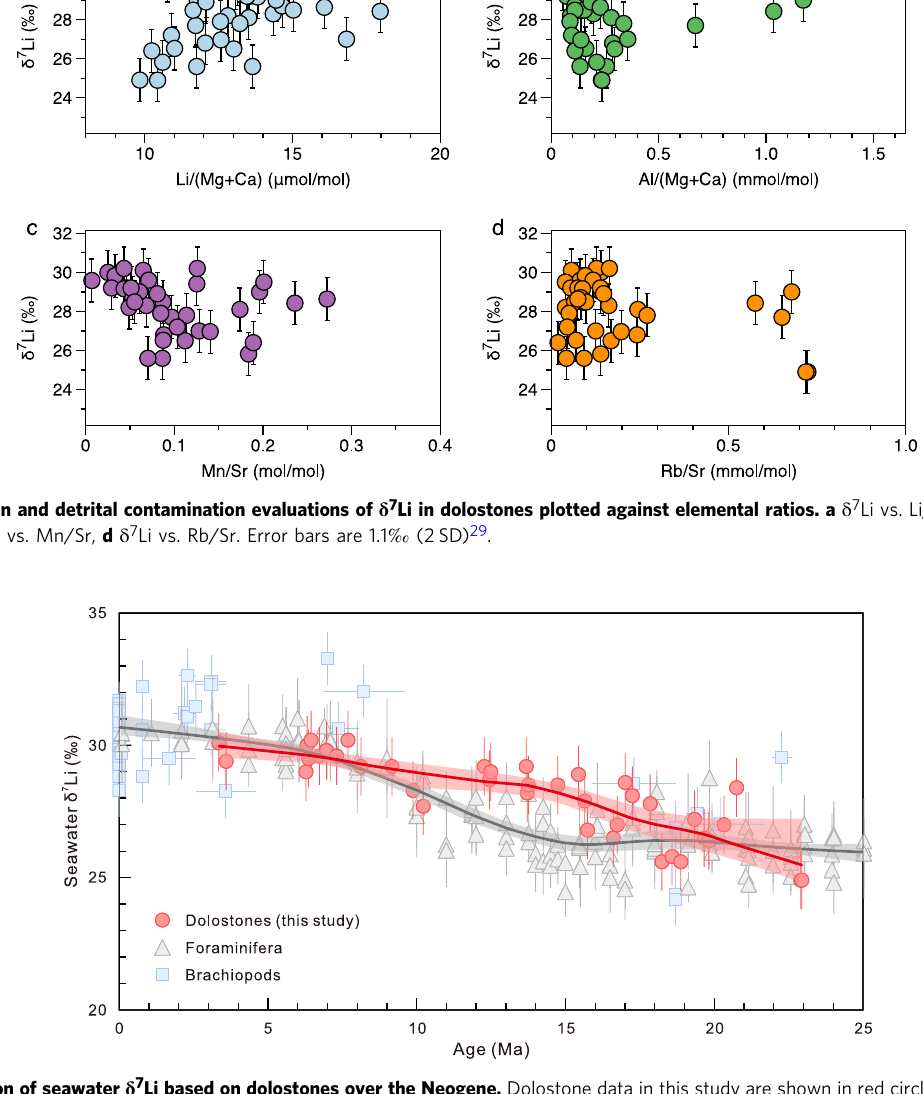
Fig. 4 Reconstruction of seawater δ 7 Li based on dolostones over the Neogene. Dolostone data in this study are shown in red circles, foraminifera data 3 are in grey triangles, and brachiopod records 10, 11, 22 are in blue squares. The red and grey lines show the best-estimated seawater value in 10 Myr intervals using the Locally Weighted Regression (LOWESS) curve fi tting based on dolostone and foraminifera data 3 , respectively. The red and grey fi elds indicate the upper and lower bounds of 95% con fi dence levels based on dolostone and foraminifera records, respectively. The vertical error bars (2 SD) for dolostone, foraminifer and brachiopod records are 1.1 ‰ 29 , varied 3 , and 1 ‰ 10 , respectively. The horizontal error bars show estimated age ranges of the brachiopod records 10